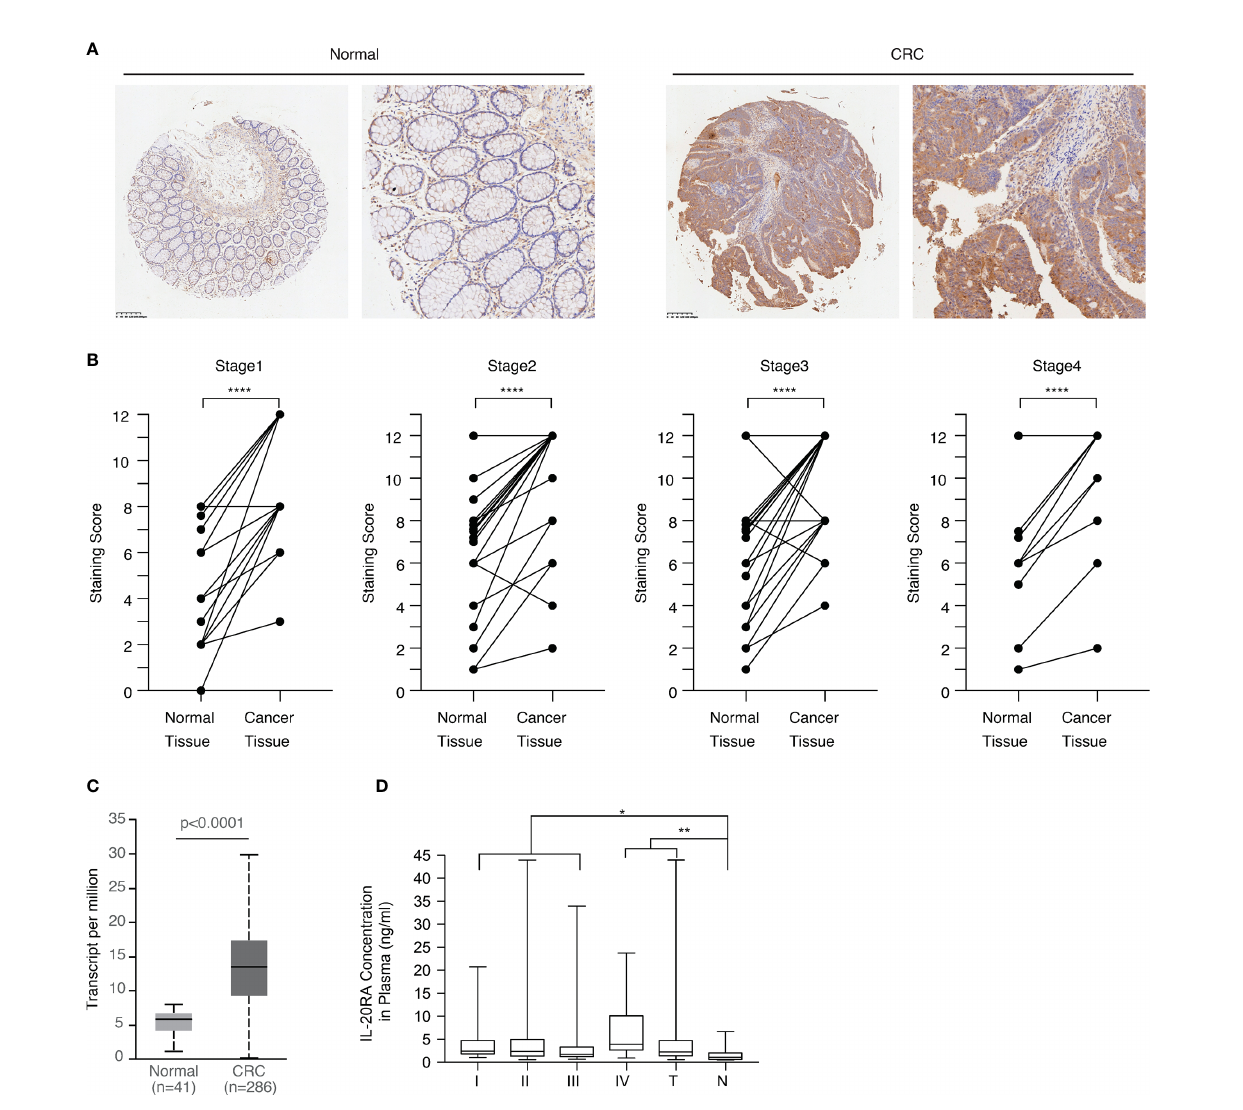
FIGURE 3 | IL-20RA was highly expressed in colorectal cancer. (A) IHC staining images of IL-20RA between colorectal cancer tissues and paired normal tissues in the microarray. (B) Statistical analysis of the IHC scores of IL-20RA in colorectal cancer and paired normal tissues of 118 human colorectal cancer patients in different UICC stages. (25 for stage 1; 42 for stage 2; 40 for stage 3; 11 for stage 4). (C) IL-20RA was highly expressed in CRC compared to normal colon tissues. The expression of IL-20RA in CRC and normal colon tissues was retrieved from the RNA-seq data of the TCGA-COAD cohort. (D) IL-20RA levels in plasma between 52 colorectal cases and 17 normal persons (10 for stage 1; 16 for stage 2; 18 for stage 3; 8 for stage 4). *P < 0.05, **P < 0.01, ****P <